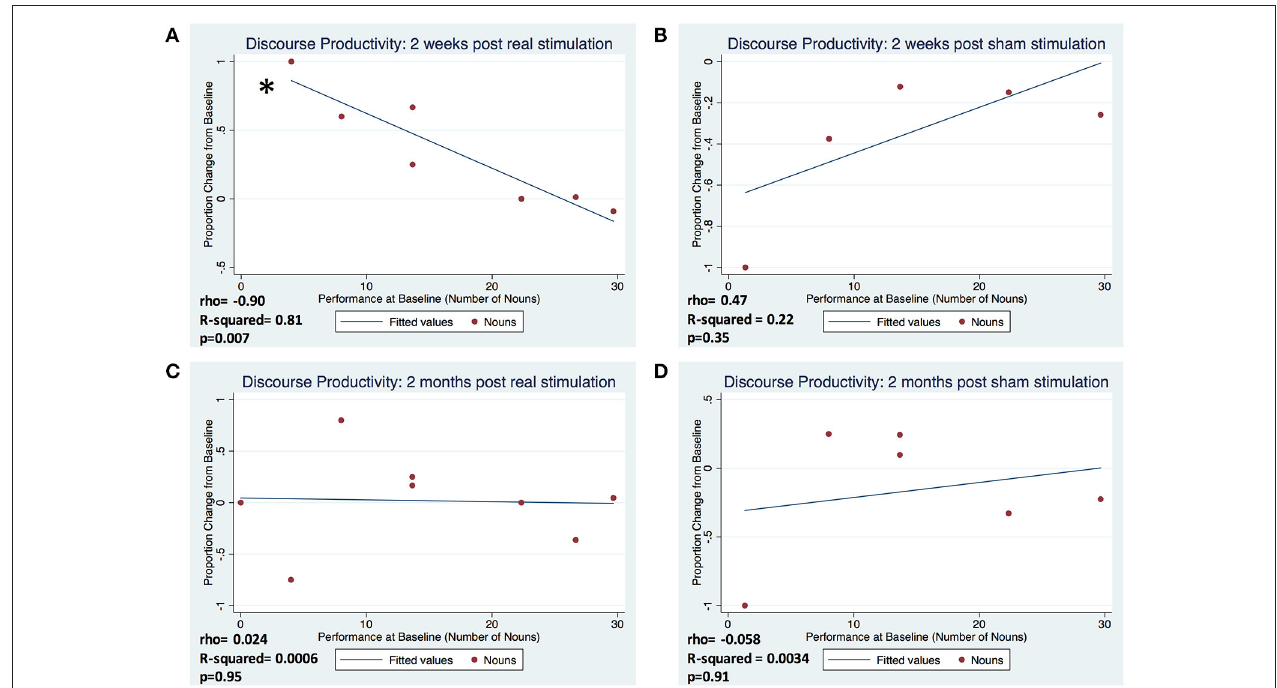
FIGURE 2 | Proportion change in baseline of discourse productivity according to average baseline performance, represented by nouns, at 2 weeks following real (A) and sham (B) stimulation and 2 months following real (C) and sham (D) stimulation. Proportion change from baseline was calculated as: (follow-up performance–baseline performance)/baseline performance. (*Represents p <